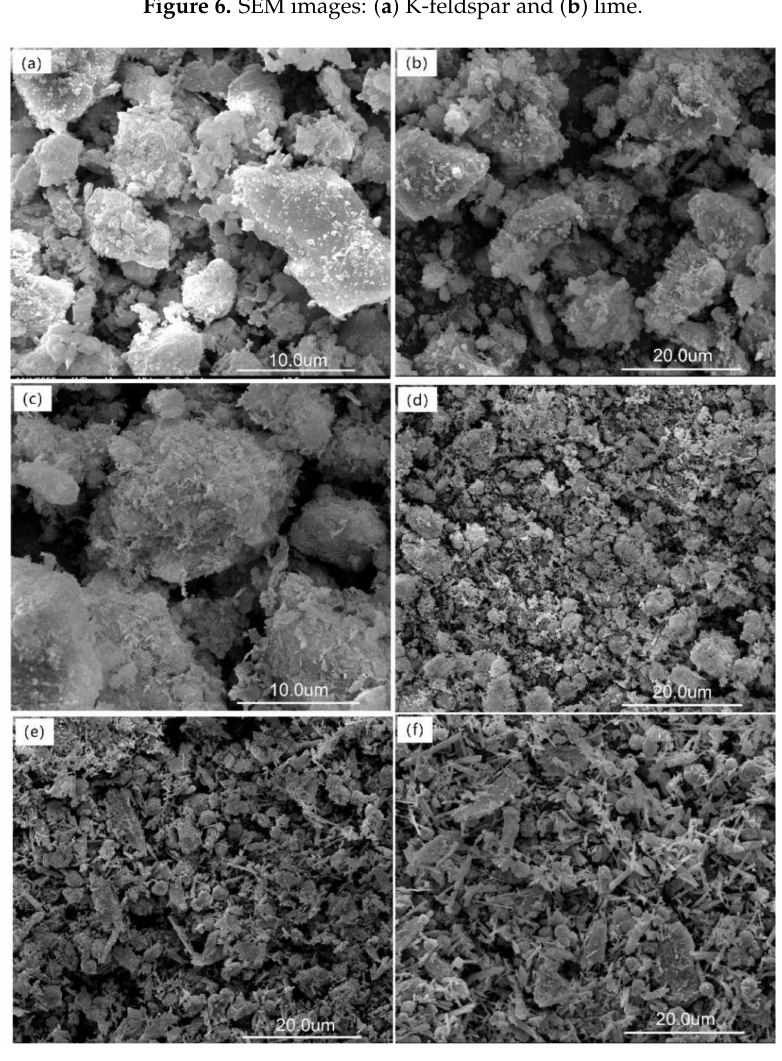
Figure 7. SEM images: ( a ) L–1; ( b ) L–2; ( c ) L–3; ( d ) L–4; ( e ) L–5 and ( f )